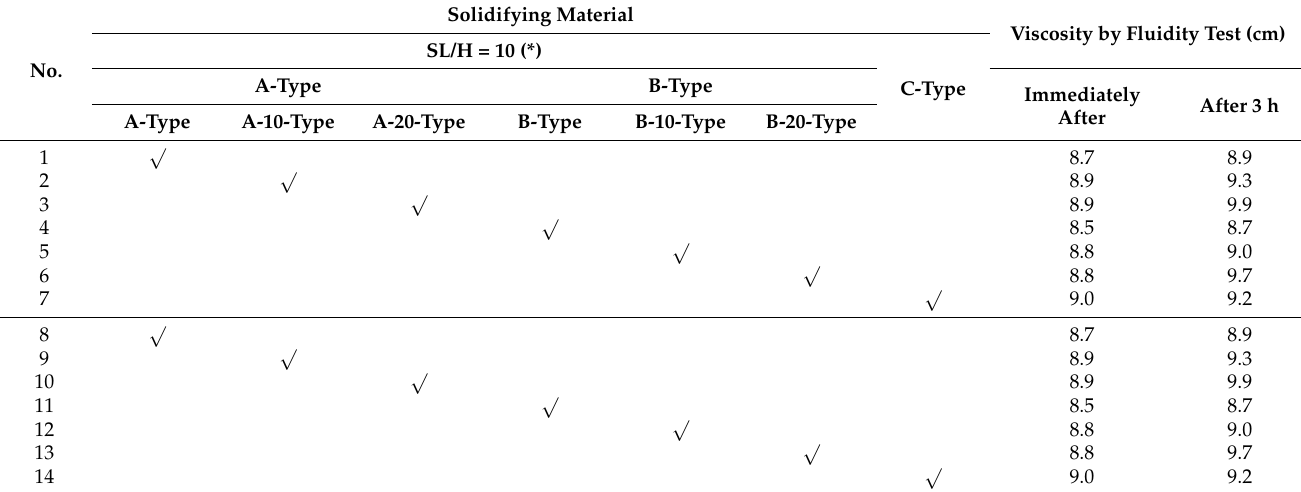
Viscosity by Fluidity Test (cm)